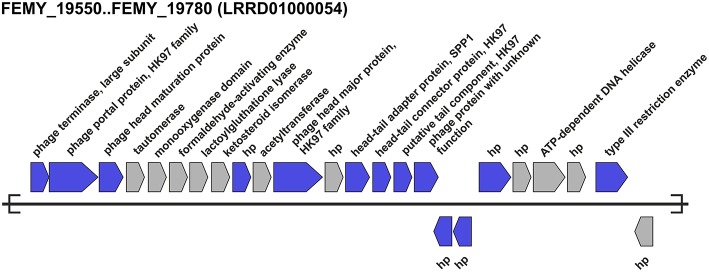
Predicted prophage fragment in the genome of “F. myxofaciens” Z-31. One contig of the “F. myxofaciens” Z-31 genome was found to harbor a cluster of predicted phage-associated genes (blue) which were identified using Prophinder (Lima-Mendez et al., 2008) by conducting blastp searches against the ACLAME database (Leplae et al., 2010). Genes encoding hypothetical proteins (hp) and genes that are not predicted to be associated with phages are shown in gray. The nucleotide accession number of the contig is given in parentheses.